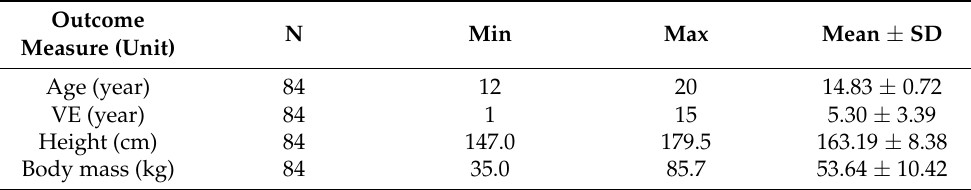
Table 1. Descriptive statistics of participants.